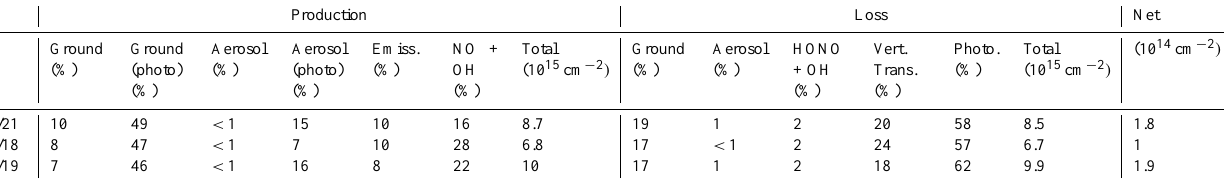
Table 3. Percentage contribution of the different HONO formation and loss processes averaged in lowest 300m above ground.